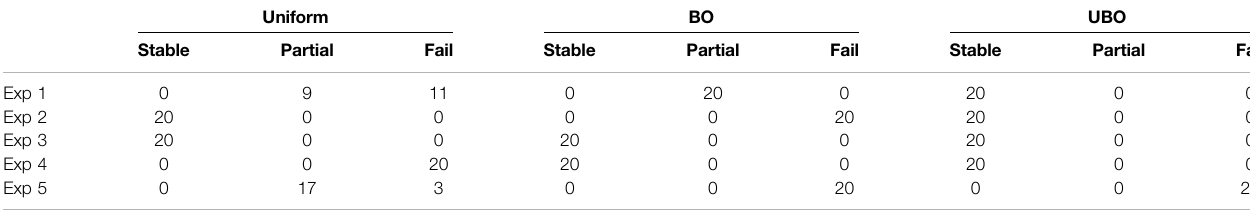
TABLE 5 | Frequency distribution of experiments on complex-shaped blue object to evaluate grasp